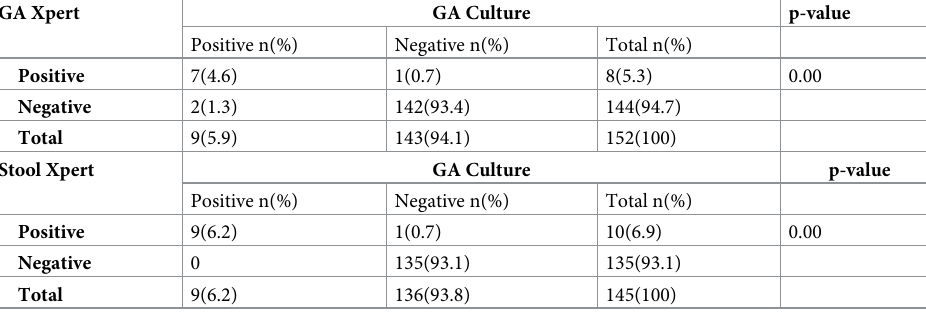
Table 2. Proportion of positive GA Xpert and stool Xpert compared to GA culture for